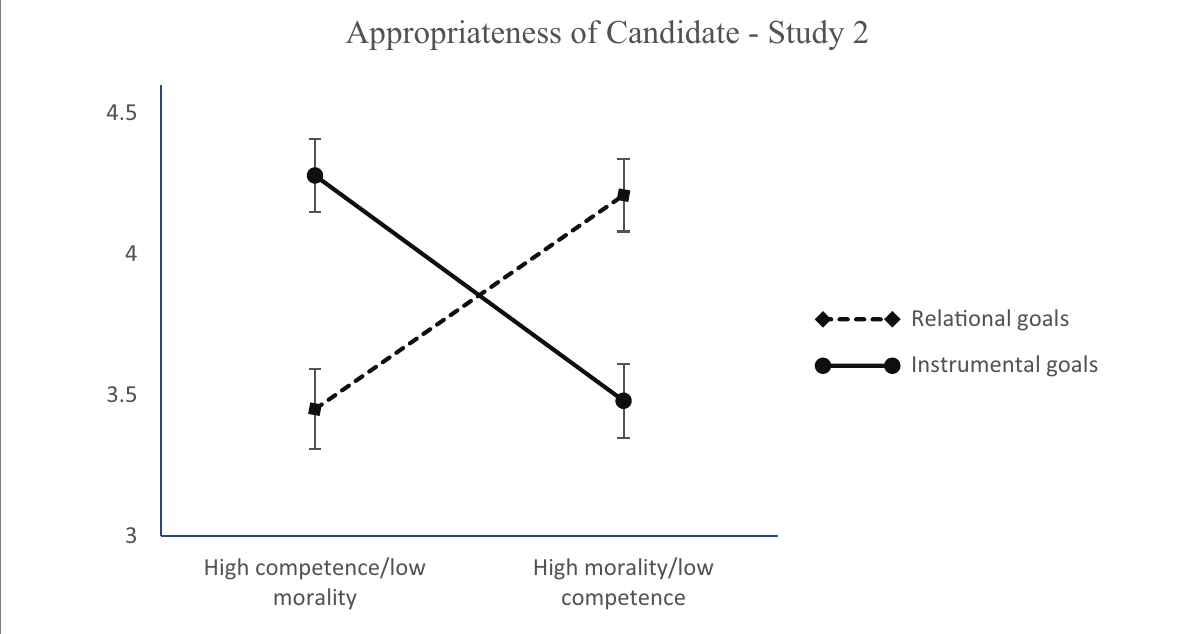
FIGURE 2 Perceived appropriateness of a candidate as a function of morality/competence and type of goals (Study 2). Ratings were on a 7-point scale (1 = not at all , 7 = to a great extent ). Error bars represent standard